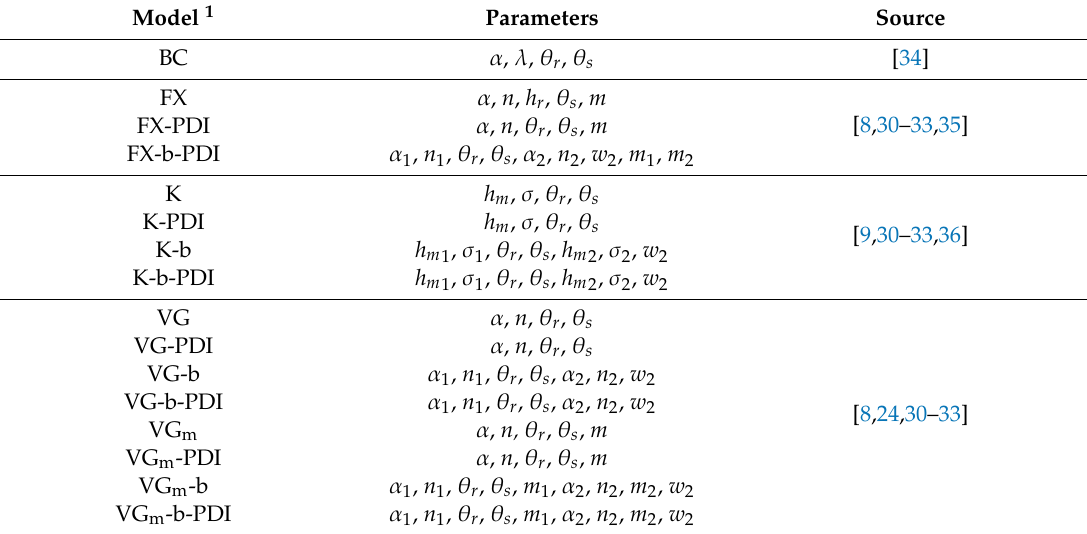
Table 2. The water retention models and their parameters estimated using parametric PTFs in this